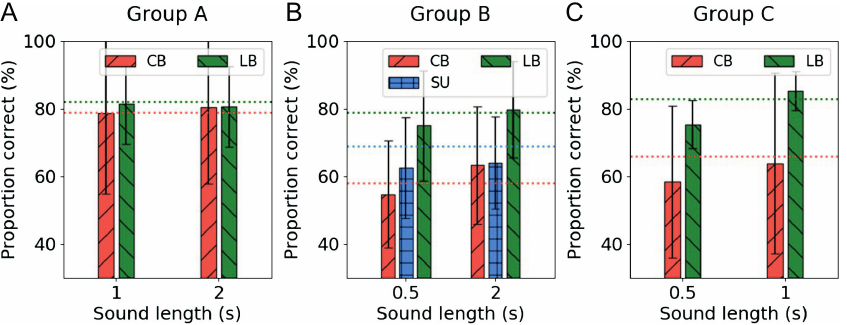
Figure 10. The recognition performance of the crossover test with different length of sounds obtained from three groups of participants. ( A ) Group A, trained with short (0.5 s) soundscapes; ( B ) Group B, trained with normal (1 s) soundscapes; and ( C ) Group C, trained with long (2 s) soundscapes. The x-axis of each figure represents the temporal length of the soundscape used for training the other groups. The dotted lines in the figures represent the mean performance of each group after five training